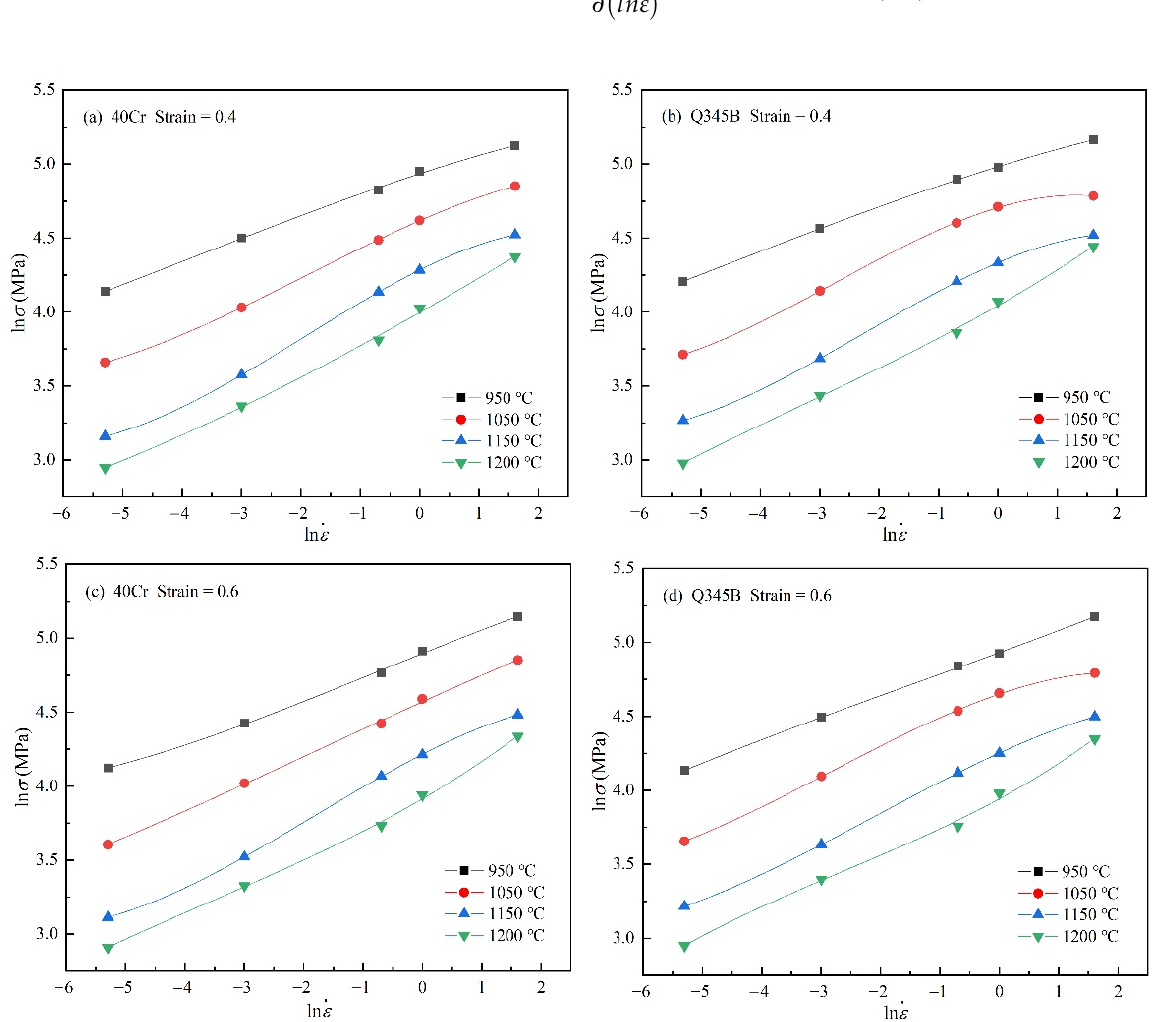
. Figure 13. Relationships between ln 𝜀(cid:4662) -ln σ for ( a ) 40Cr, 𝜀 = 0.4, ( b ) Q345B, 𝜀 = 0.4, ( c ) 40Cr, 𝜀 = 0.6, Figure 13. Relationships between ln ε − ln σ for ( a ) 40Cr, ε = 0.4, ( b ) Q345B, ε = 0.4, ( c ) 40Cr, ε = 0.6, and ( d ) Q345B, 𝜀 = 0.6. and ( d ) Q345B, ε =